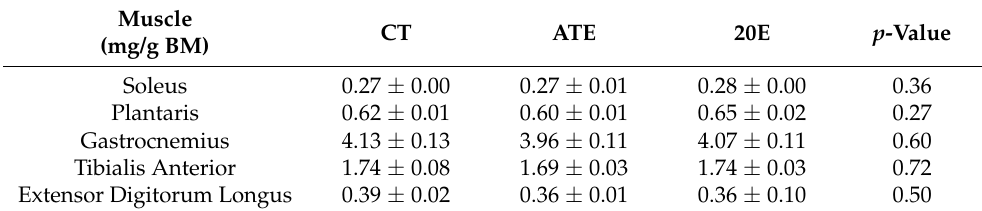
Table 2. Hindlimb muscle wet